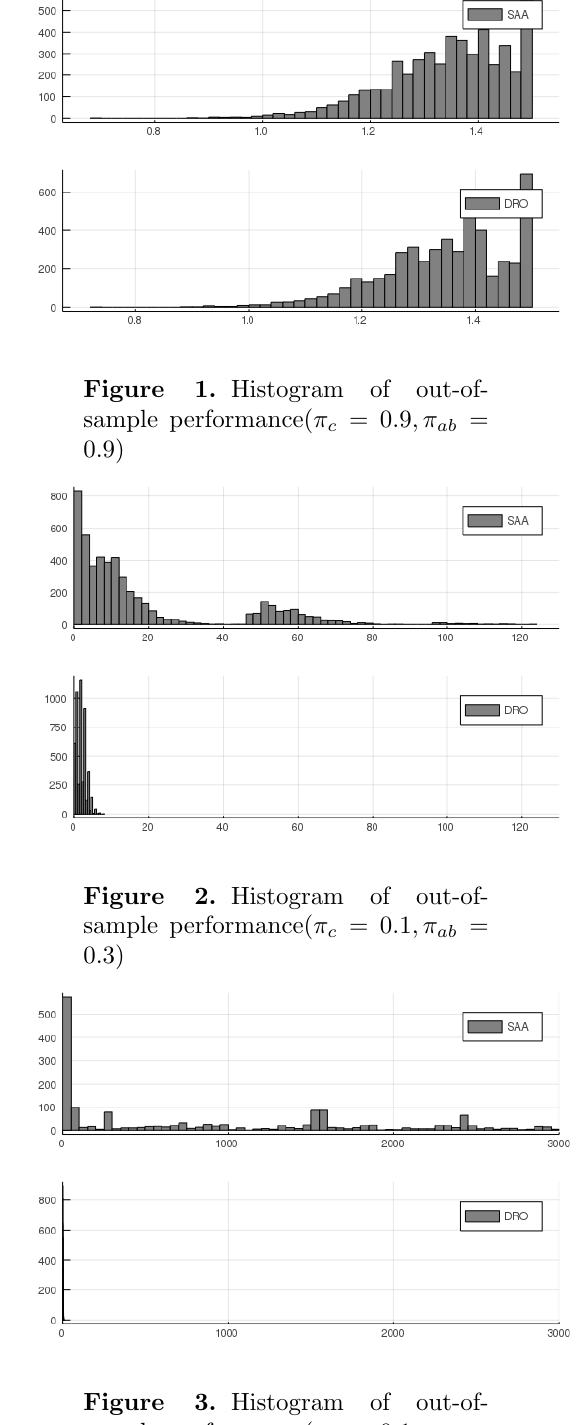
Figure 3. Histogram of out-of- sample performance( π c = 0 . 1 , π ab = 0 .